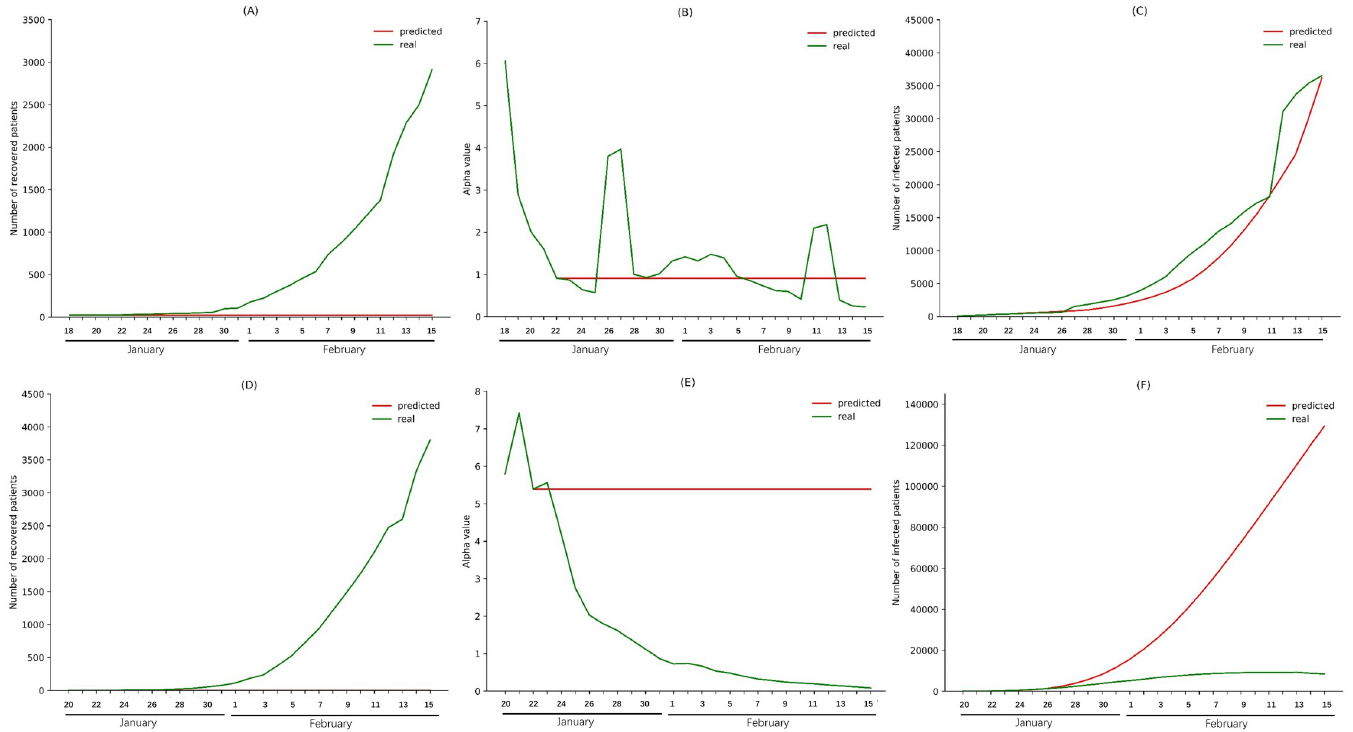
Fig 3. Impact of city lockdown on Wuhan city and China excluding Hubei province. (A) The φ values for Wuhan city at January 22 (before city lockdown) were used to predict the φ values from January 23 to February 15 without city lockdown. (B) The α values for Wuhan city at January 22 (before city lockdown) were used to predict the α values from January 23 to February 14 without city lockdown. (C) Predicted α values and φ values were used to calculate the number of infections in Wuhan city from January 24 to February 15. (D) The φ values for China excluding Hubei province on January 22 were used to predict the φ values from January 23 to February 15 without city lockdown. (E) The α values for China excluding Hubei province on January 22 were used to predict the α values from January 23 to February 14 without city lockdown. (F) Predicted α values and φ values were used to calculate the numbers of infections in China excluding Hubei province from January 24 to February 15.